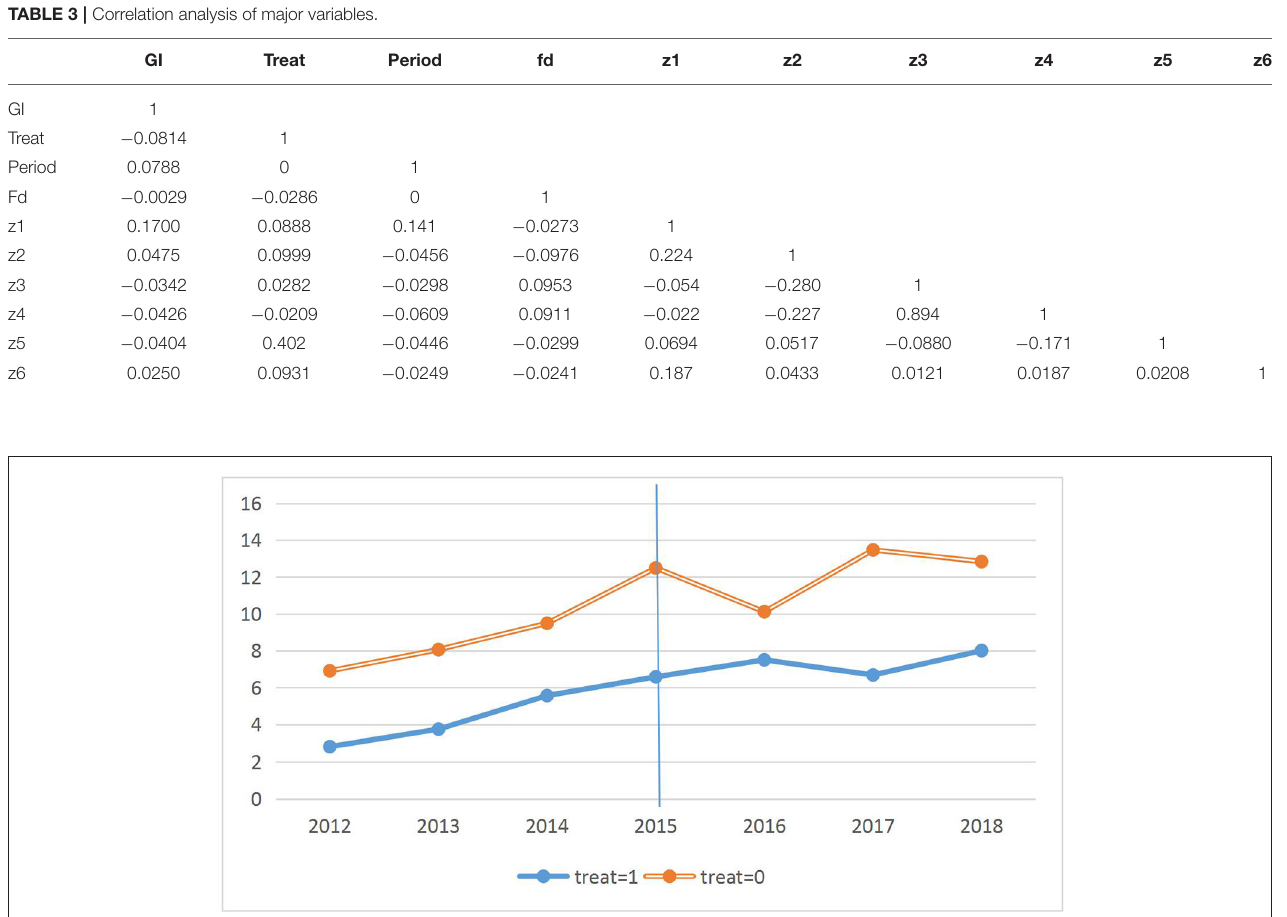
FIGURE 1 | Parallel trends of green innovation of enterprises (regions with high degrees of fiscal decentralization).